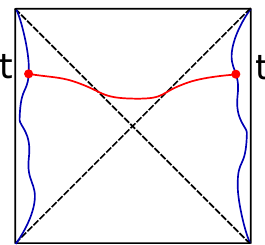
Figure 7 . Extremal wormhole in the bulk geometry of the thermal system, anchored at both boundaries at time t